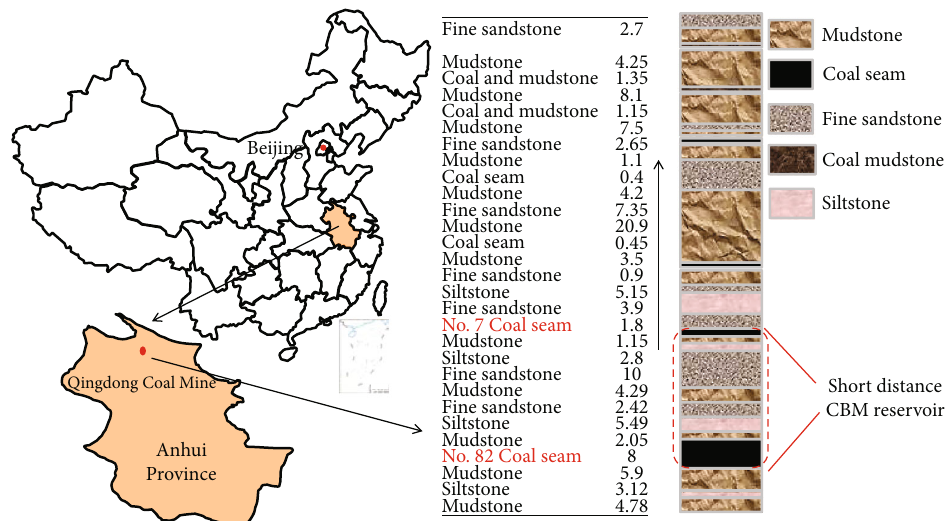
Figure 1: The CBM reservoir group and the occurrence of coal seam and rock